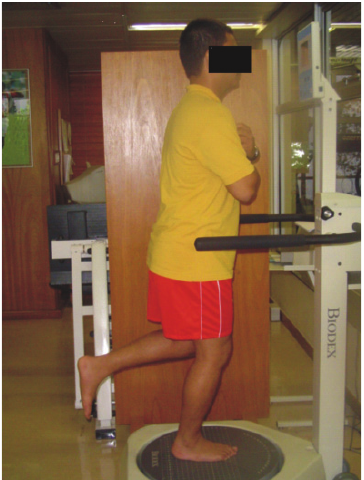
Figure 1 - The Biodex Balance System.